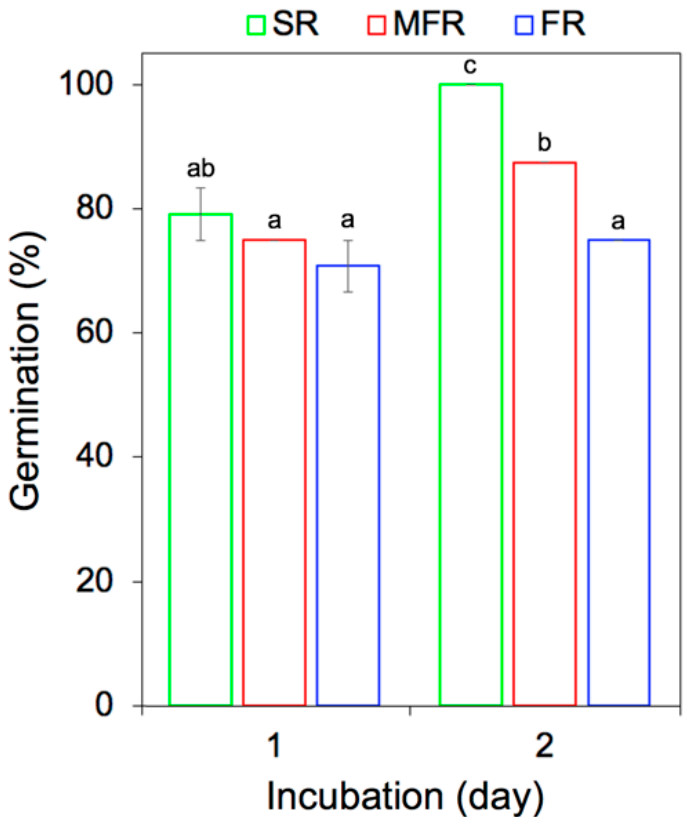
Figure 2. In vitro seed germination (%) under the different biotic conditions. The seed surrounded by the mycoparasite S. mycoparasitica against F. graminearum (MFR, red square line); the seed infected by F. graminearum (FR, blue square line); the non-treated or non-infected seed (SR, green square line). The germination (%) was calculated by the ratio of the number of germinated seeds for each treatment over the number of germinated seeds at day 2 control multiplied by 100. The presented bars are means of three sets of germination (%) with standard errors. The different letters (a–c) indicate statistically significant differences ( p < 0.05) according to Tukey’s honestly significant difference test.